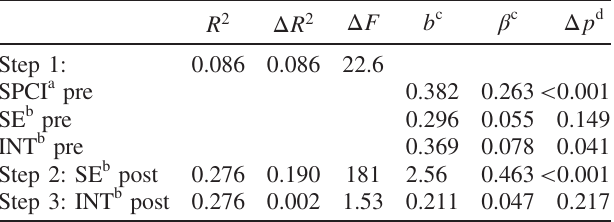
TABLE VI. Sequential multiple regression parameters explain- ing understanding of star properties after instruction (SPCI